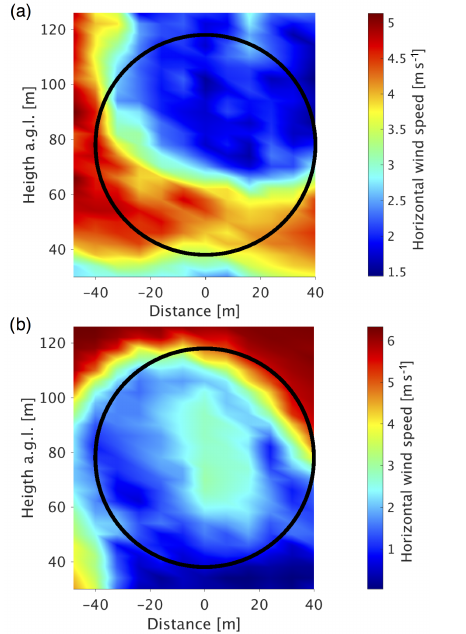
Figure 10. Wake displacements as a function of the time of the day: (a) direction of displacement relative to one over the Obukhov length; (b) wake deflection angles according to the cross-sectional model. The error indicates the sensitivity to the wake expansion an- gle for changes of (cid:49)(cid:50) = ± 2 ◦ . For periods with a straight wake propagation (case 3), the error indicates the range of (cid:50) for which wakes are fully covered by the diamond scan.